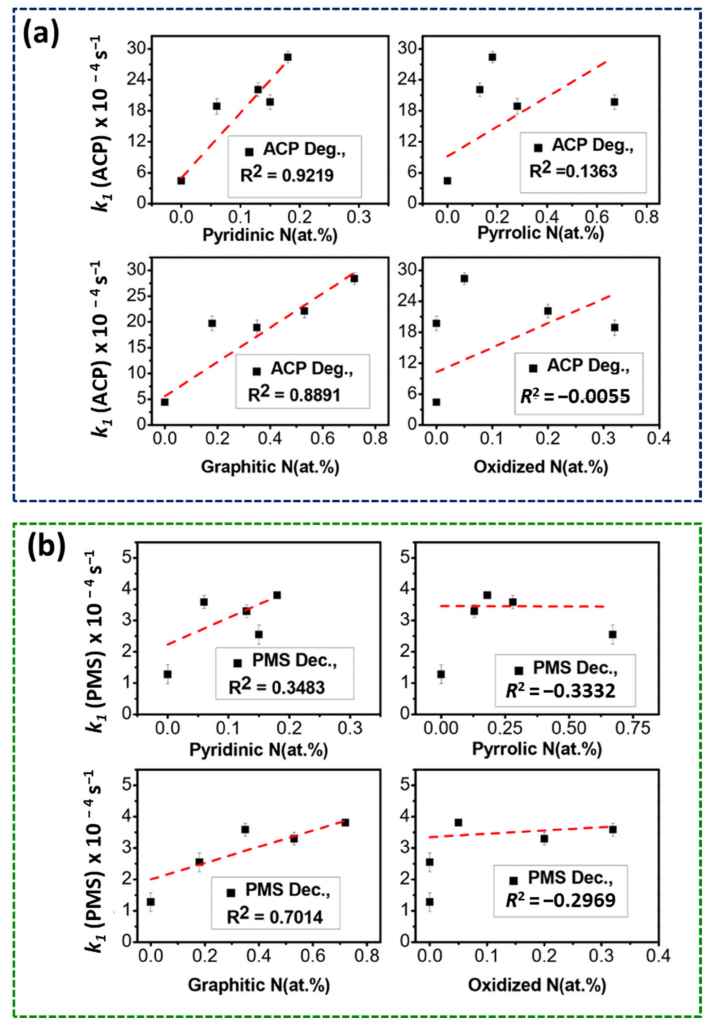
Figure 2. Role of N-content and specific N-constituent in k 1 (ACP) ( a ), and k 1 (PMS) ( b ). Experimental conditions C ACP = 10 mg L − 1 , C Catalyst = 100 mg L − 1 , C PMS = 0.5 mM and pH 0 = 7 ±